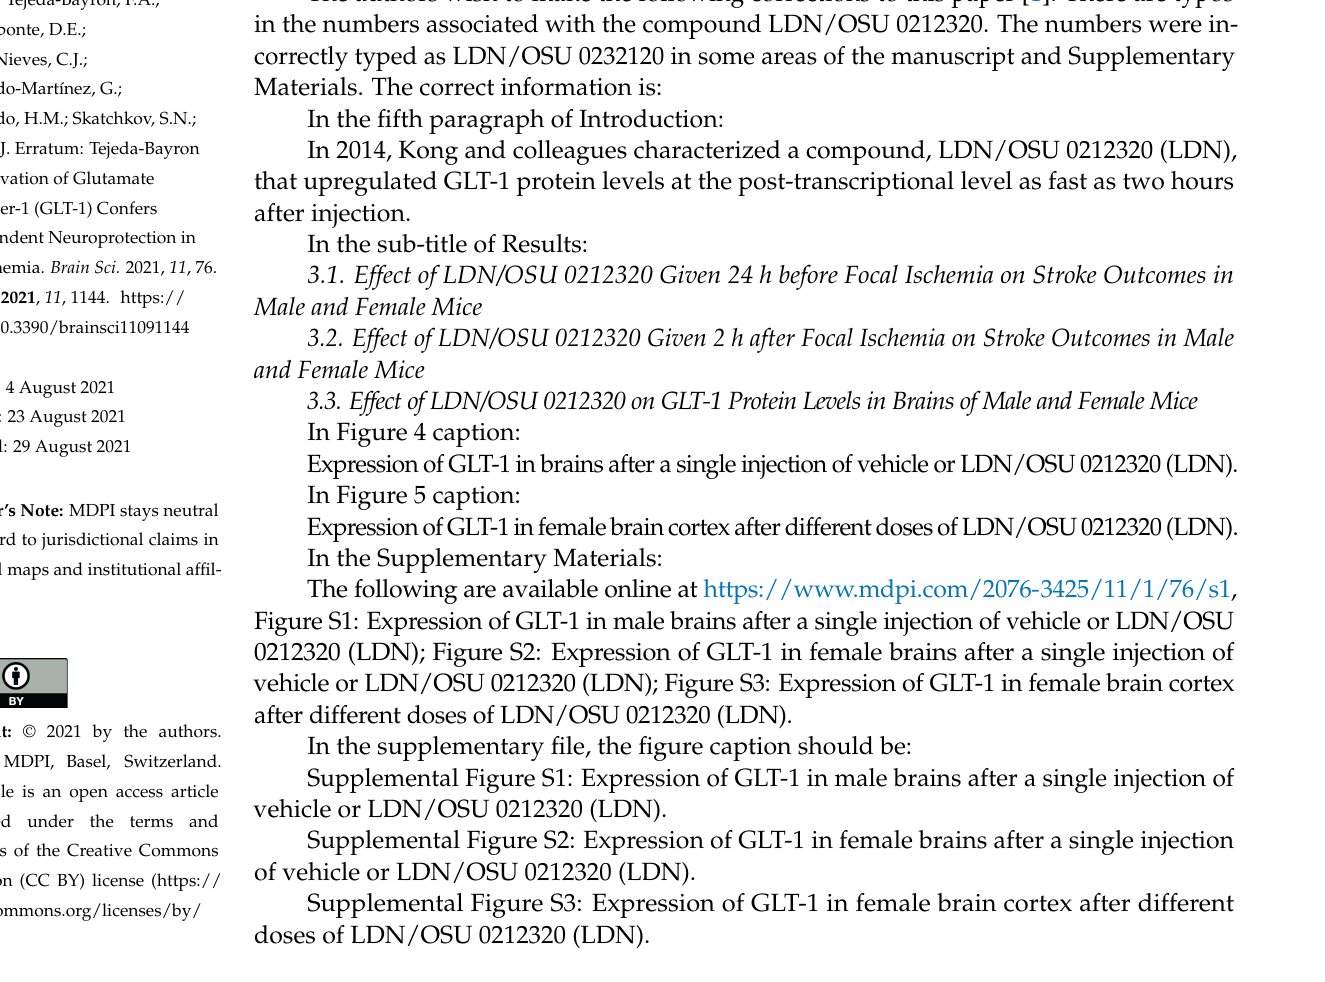
Supplemental Figure S2: Expression of GLT-1 in female brains after a single injection of vehicle or LDN/OSU 0212320 (LDN). Supplemental Figure S3: Expression of GLT-1 in female brain cortex after different doses of LDN/OSU 0212320